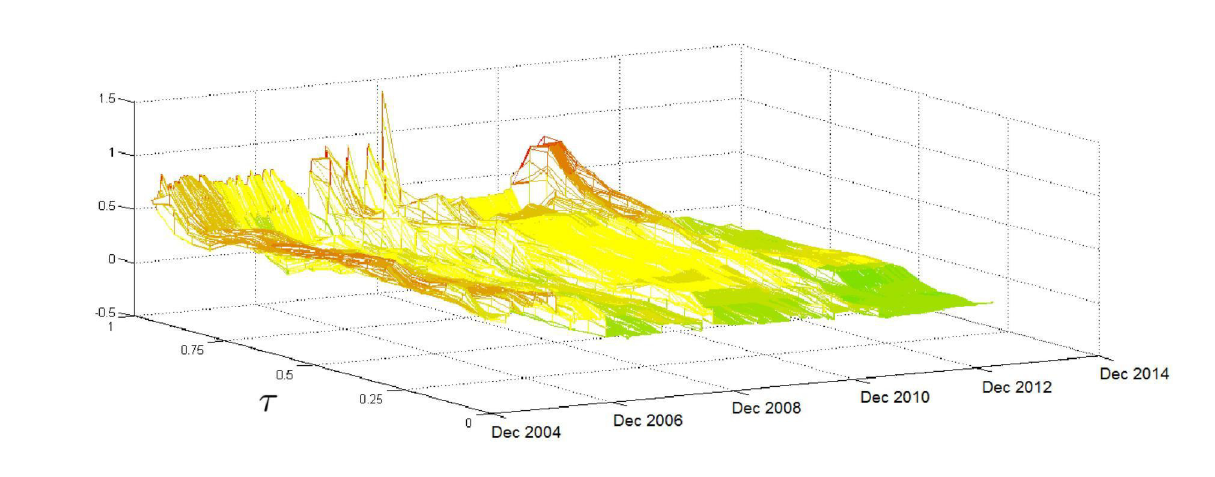
Figure 3. Rolling analysis for f pc 5